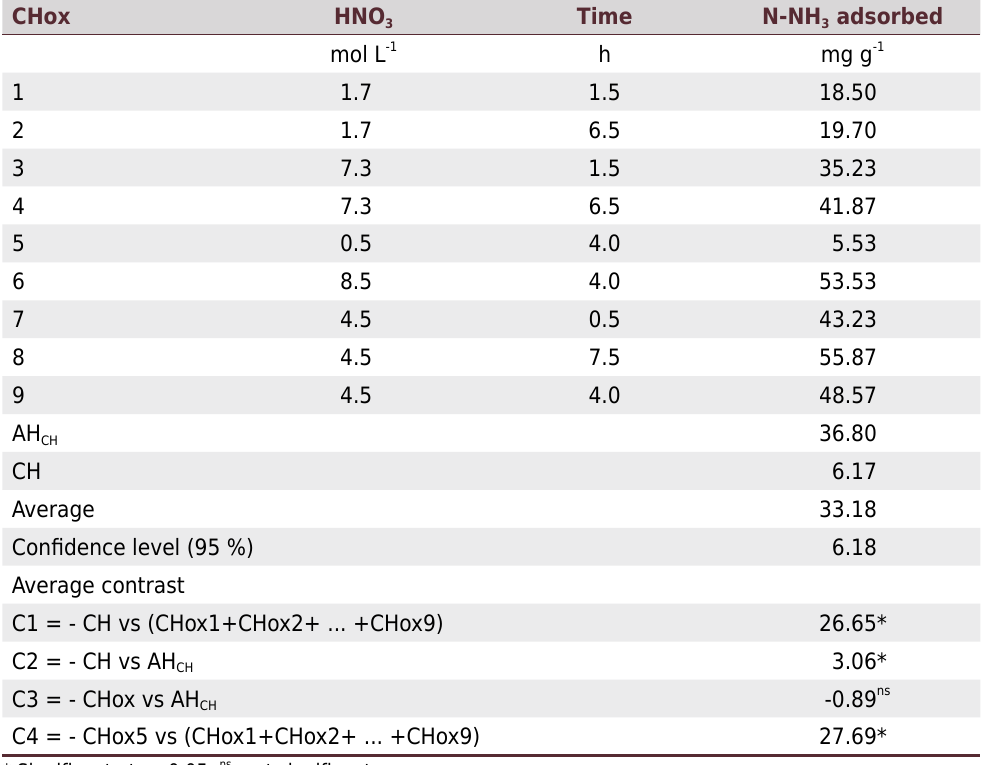
Table 5. The N-NH 3 adsorbed by functionalized charcoals (CHox) produced according to the concentration of HNO 3 and the reaction time, for the humic acid obtained from charcoal (AH CH ) and eucalyptus charcoal (CH), and the average contrasts between the amounts of N adsorbed in treatments associated with statistical significance CHox